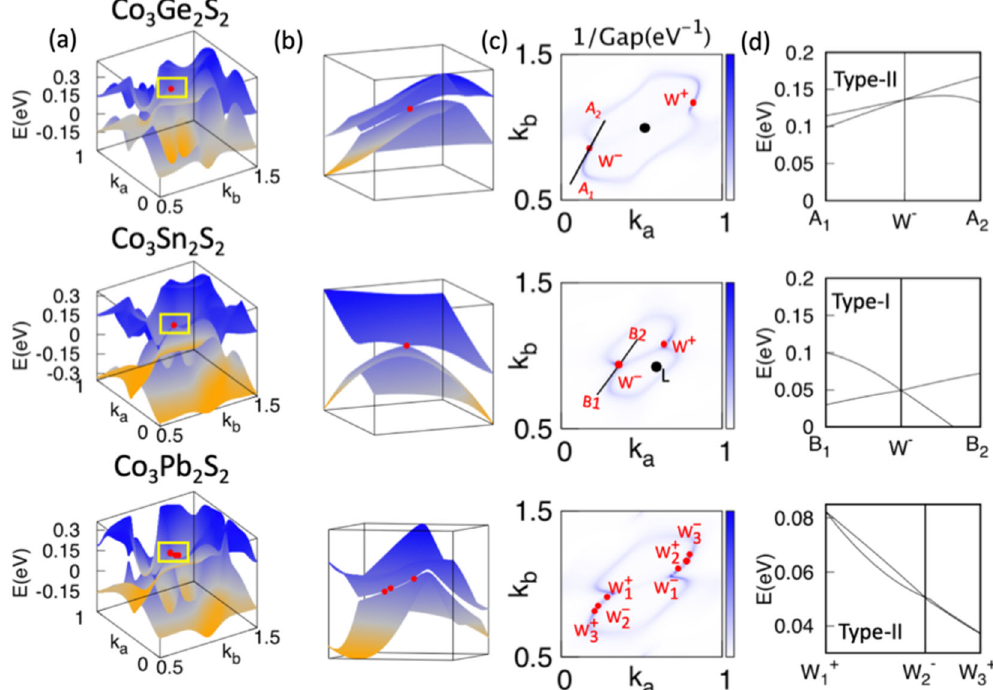
Fig. 3 Energy bands and energy gaps for Co-M-S compounds. a 2D plots of conduction and valence bands in k b = k c mirror plane for Co-M-S systems. b Enlarged data points of the region highlighted by the yellow lines in a . c 2D maps of the inverse energy band gaps (1/gap) in the k b = k c mirror plane. If the gap is large, the value of 1/gap is small (white color). Nodal lines open up small bandgaps with SOC, resulting in the high-intensity blue lines in the 1/gap curve. The red points highlight the Weyl points (W) with “ + ” and “ − ” signs indicating their chiralities. d Energy plots along the lines tangential to the Weyl points highlighted in c , identifying the types of Weyl points. The top, middle, and bottom panels are data for Co-Ge-S, Co-Sn-S, and Co-Pb-S,